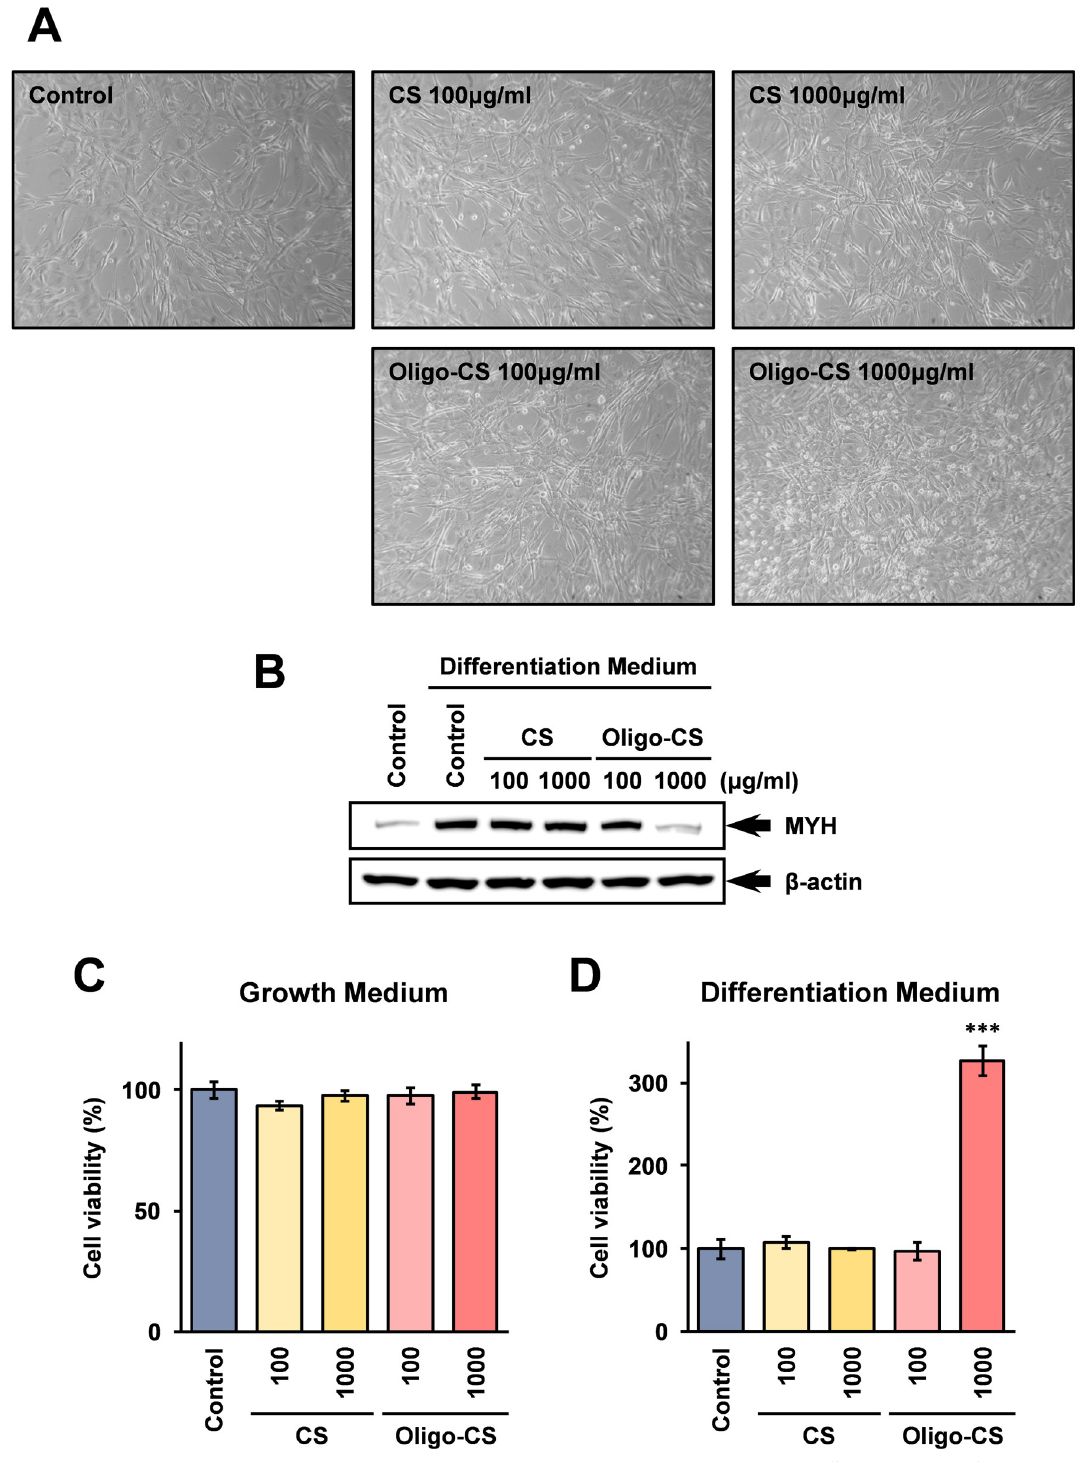
Fig 4. Oligo-CS increases cell viability of C2C12 cells in myotube differentiation medium. C2C12 cells were grown in the differentiation medium with the indicated concentrations of CS or Oligo-CS to differentiate into myotube cells for 72 hours as described in the Materials and Methods. (A) Morphological changes of the C2C12 cells were monitored by phase contrast microscopy. (B) Protein expression of myosin heavy chain (MYH) in C2C12 cells grown in differentiation medium was analyzed by Western blotting. The whole cell lysate containing 10 μ g protein was applied to each lane. Anti- β -actin antibody was used for the